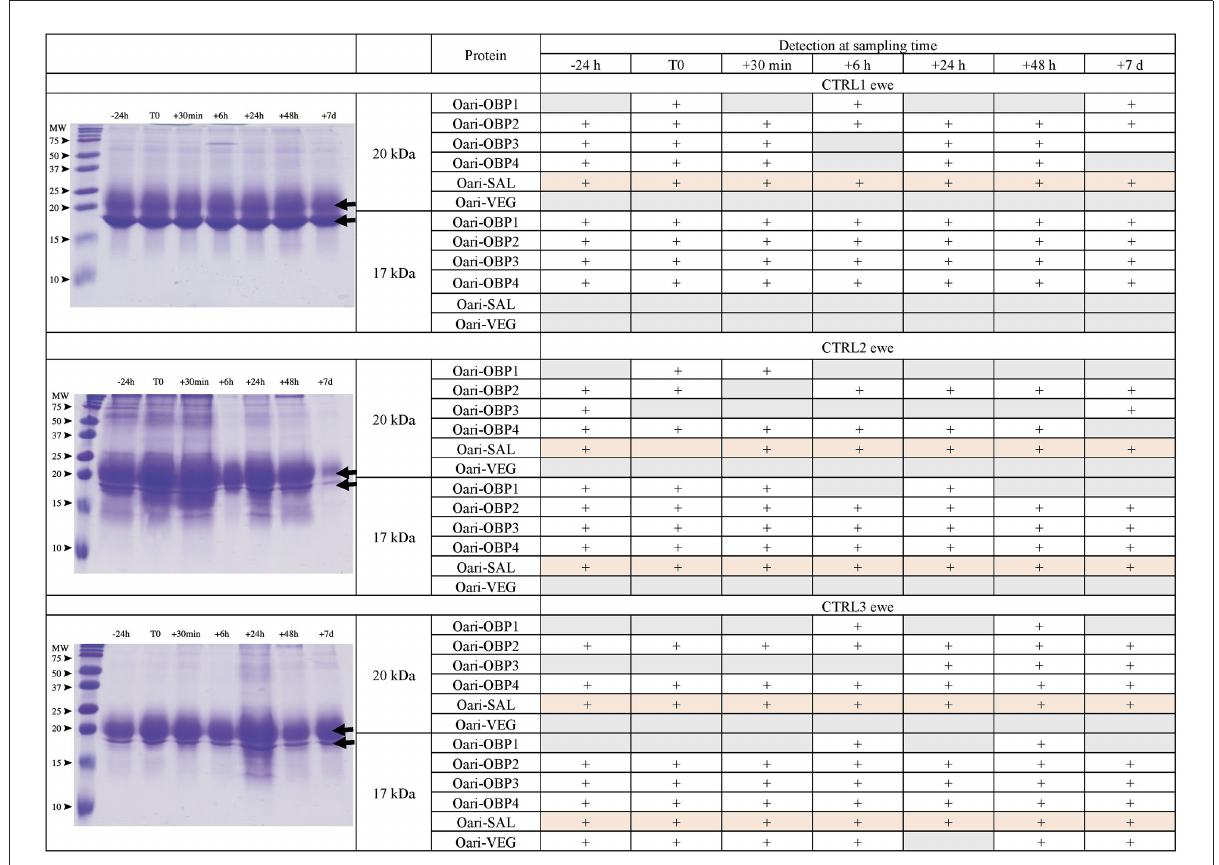
FIGURE2 Analysis of olfactory secretome of control ewes. (Left) One-dimension separation (SDS-PAGE) of total soluble proteins extracted from nasal mucus at different sampling times. Coomassie blue staining. Molecular weight marker, Precision Plus Protein Standard Dual Color (Bio-Rad). Arrows indicate the 17 and 20 kDa migrating bands, the protein composition of which was determined by MALDI-TOF MS and is given in tables on the (Right) .